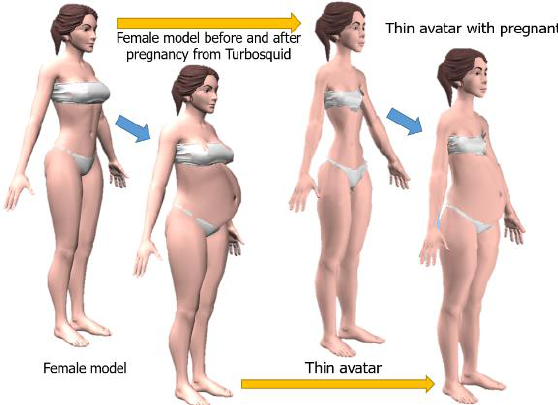
Figure 2. Creating a thin pregnancy avatar.